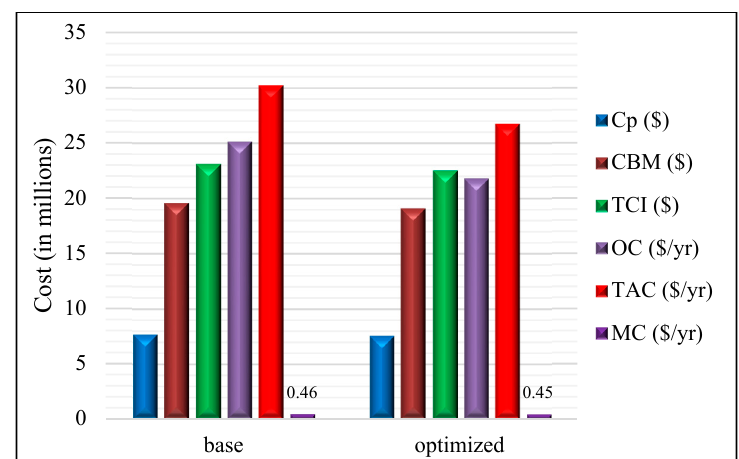
Figure 12. Economic analysis of SMR LNG process.